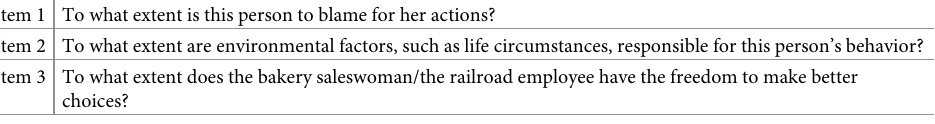
Table 2. Measurement of attribution.